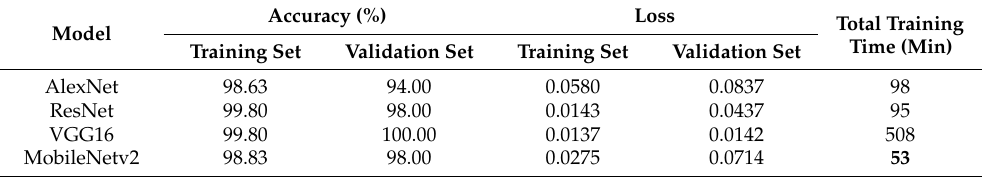
Figure 12. Results of vehicle weights identification of different models: ( a ) Training accuracy curves of response samples; ( b ) Training loss curves of the response samples; ( c ) Validation accuracy curves of the response samples; ( d ) Validation loss curves of response samples. Table 7. Train results of vehicle weight identification of different models after 50